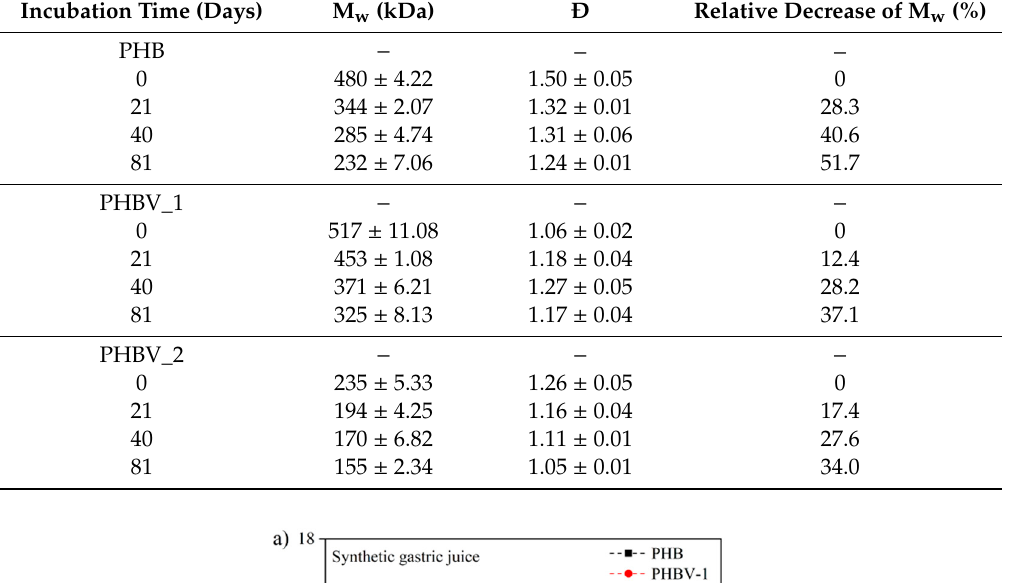
Table 5. Molecular weight changes in the PHA sca ff olds in vitro at 37 ◦ C in synthetic gastric juice determined by SEC-MALLS. Ð: polydispersity.